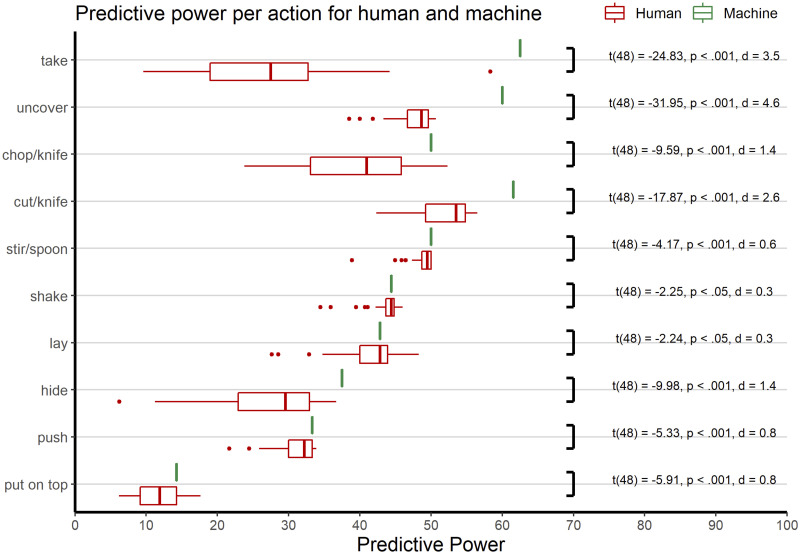
Fitting different models to the actions.(Abbreviations are shortened to allow to encode combinations by a short “+” annotation. We have Touch = T = TNR, Static = S = SSR, Dynamic = D = DSR. This leads to different combinations: T+S, T+D, S+D, T+S+D, where “Overall” refers to treating all eSEC columns independently of their individual information contents (see Methods).